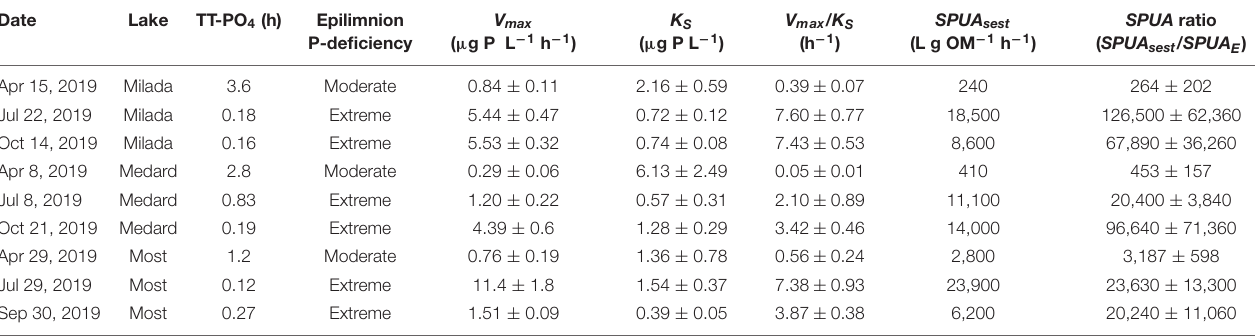
TABLE 5 | A summary of estimates of kinetic parameters ( V max and K S of Michaelis–Menten kinetics and specific P uptake affinity, SPUA sest ) of P uptake by seston in lake water in three post-mining lakes in the Czech Republic in